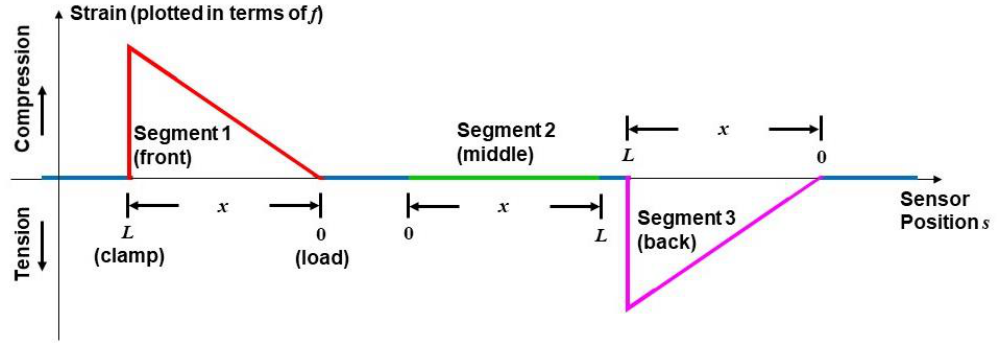
Figure 4. Predicted strain measured by the embedded DOFS (plotted in terms of GHz) for the specimen in Figure 1, as functions of sensor position s or beam position x .